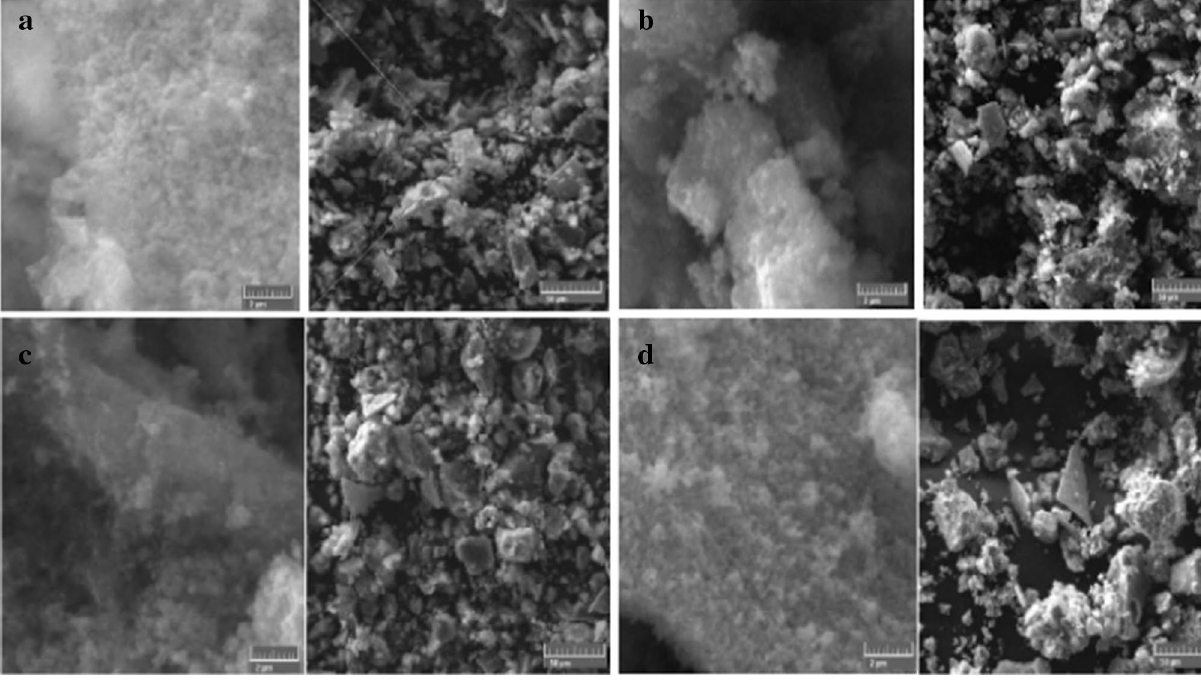
Fig. 8 SEM images of TiO 2 at calcination temperature, a 300 °C b 500 °C c 700 °C d 900 °C (Yudoyono et al.